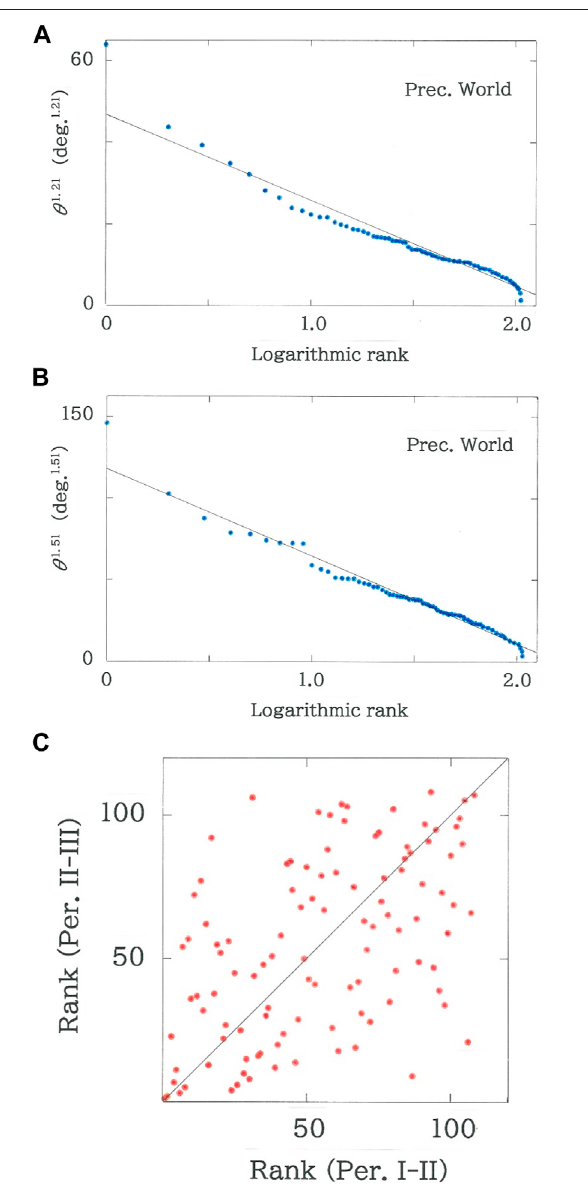
FIGURE 4 | Rank dependence of the cross angles of the monthly precipitations on the World stations. (A) From Period I (from 1931 to 1960) to Period II (from 1951 to 1980). The line indicates the optimized fi t (| r | (cid:1) 0.9675 with d (cid:1) 0.409for q (cid:1) 1.21and n (cid:1) 106). (B) FromPeriodII(from1951to 1980)toPeriod III (from1981to2010). Thelineindicates theoptimized fi t(| r | (cid:1) 0.9863 with d (cid:1) 0.709 for q (cid:1) 1.51 and n (cid:1) 107). (C) Scattergram ofrank data of Period II to III versus the data of Period I to II ( r S (cid:1) 0.5183 with d (cid:1) 1.994 for n (cid:1)